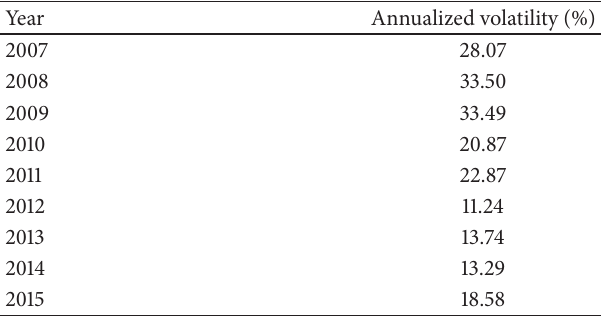
Table 3: The annualized volatility values of spot copper price in China from 2007 to 2015.